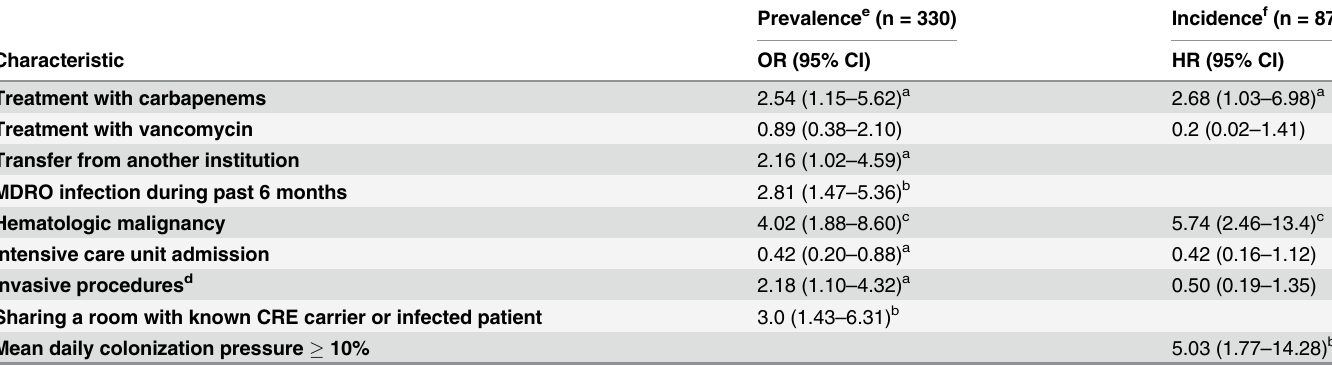
Table 3. Characteristics Associated to Carbapenem-Resistant Enterobacteriaceae Fecal Carriage by Multivariate